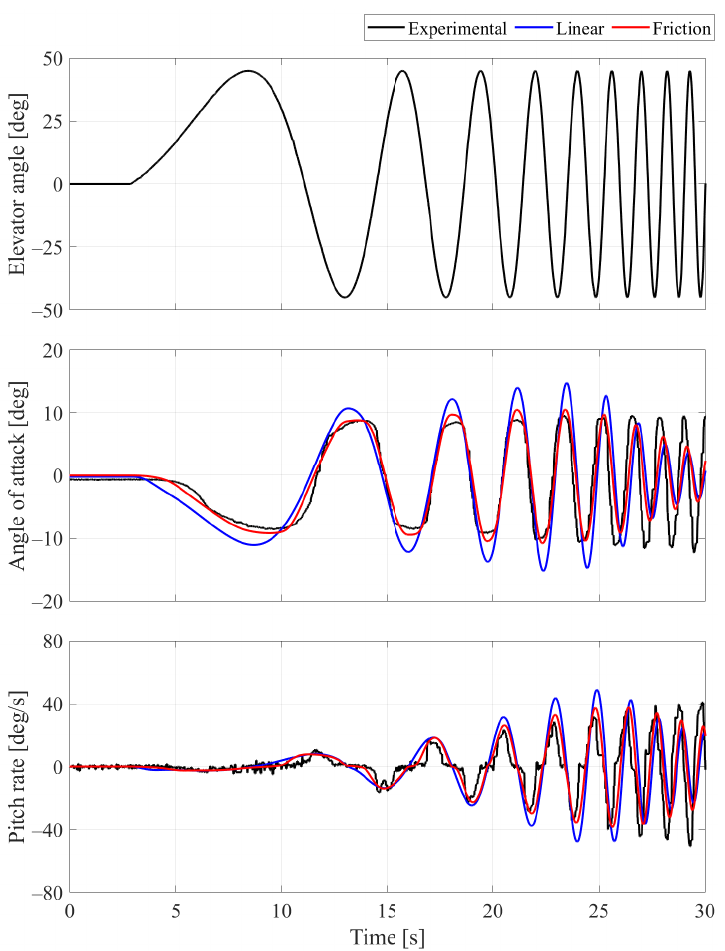
Figure 2. Elevator command ( top ) and related angle of attack ( middle ) and pitch rate ( bottom ) responses at a wind speed of 14